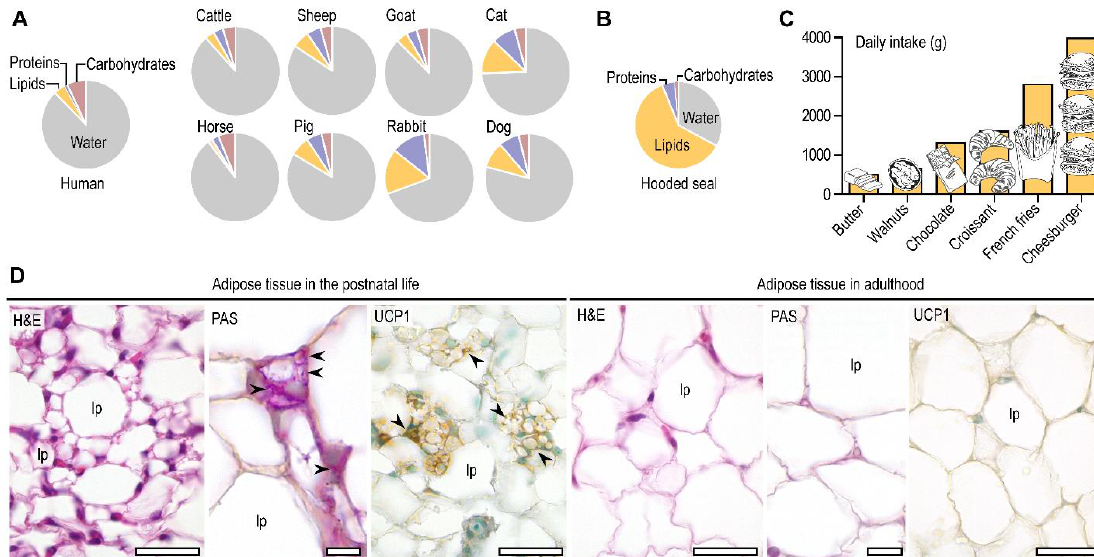
Figure 1. Fat intake and adipose tissue during postnatal life. ( A ) Composition of the breast milk in humans and various mammals. ( B ) Composition of breast milk in the hooded seal Cystophora cristata , which is recognized as the most fat-rich breast milk among mammals [65]. ( C ) Illustration of the daily fat intake of a breastfed newborn human infant extrapolated to a human adult. The graph shows the weight of various food items which provide the daily fat intake of a breastfed infant (e.g., fat content of ~1250g chocolate is equivalent with the daily fat intake of a breastfed infant). ( D ) Histology of the subcutaneous adipose tissue after birth and in adulthood in the mouse [17]. Notably, the infant adipose tissue is rich in multilocular (“beige”) adipocytes, contains PAS + glycogen granules, and expresses UCP1 protein. These traits allow an active lipid catabolism, lipid synthesis from glycogen, and heat generation from fatty acid oxidation. In turn, the adult adipose tissue is built up from unilocular adipocytes, which do not store glycogen, nor express UCP1. Postnatal development of the subcutaneous adipose tissue is associated with a shift from lipid catabolism and thermogenesis to lipid storage and thermal insulation [17]. H&E, hematoxylin and eosin; PAS, periodic acid Schiff (staining glycogen); UCP1, uncoupling protein 1 (immunohistochemistry); lp, lipid droplet. Arrowheads label glycogen granules and UCP1 + cell clusters. Scale bar 50 μm.